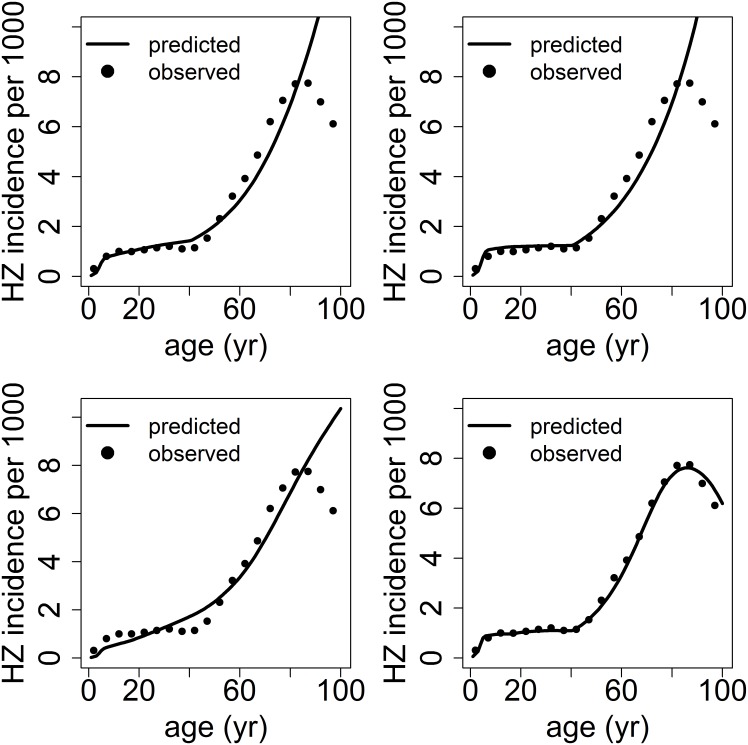
The natural history of VZV in Norway: Fit to age-specific HZ incidence by some models for VZV reactivation (Table 1) under the full boosting hypothesis (z = 1).Top-left: the “duration since exposure” model; top-right: the Gompertz age-dependent model; bottom-left: the baseline model; bottom-right: the progressive immunity model. The underlying transmission model is based on the synthetic matrix, hypothesis Q3, 16. HZ incidence is represented per 1000 population, per year.